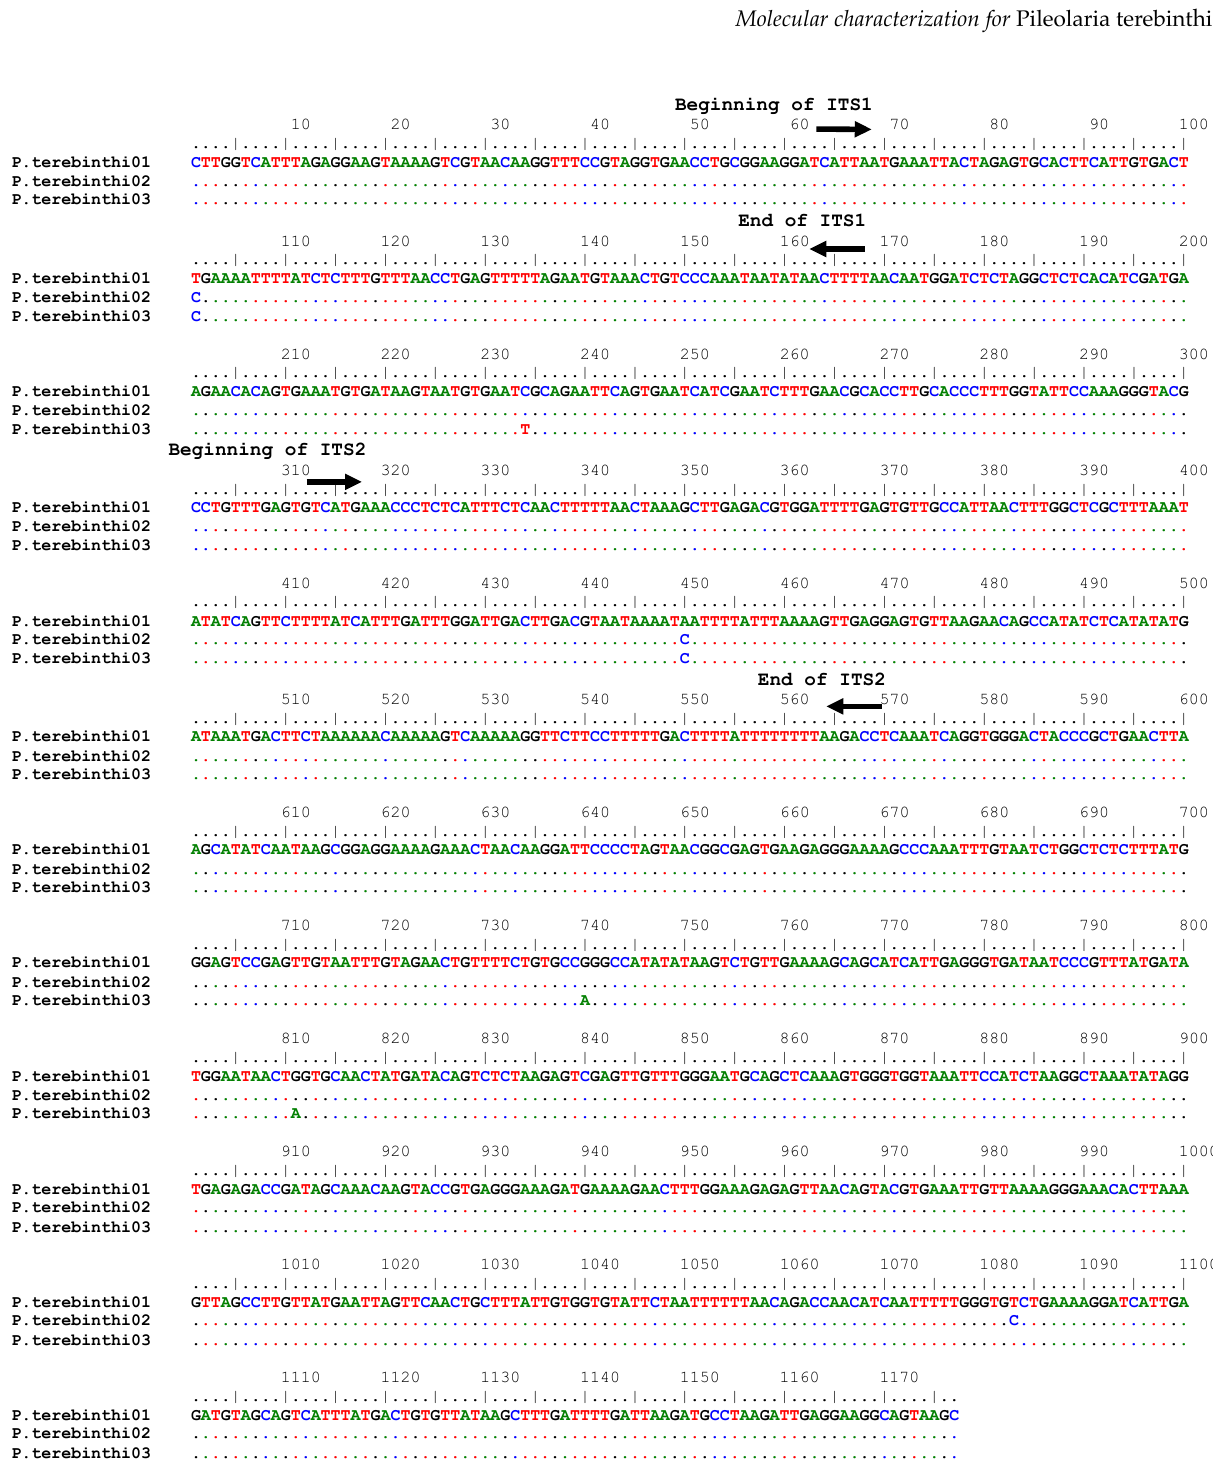
Figure 2. The complete ITS sequence alignment of Pileolaria terebinthi sample R291. The sequences are written 5’ to 3’. Iden - tical nucleotides are indicated by dots. The ITS1 and ITS2 regions are marked with arrows. The sequence was conserved in all samples which differed at position 101, 234, 358 (T instead of C); at position 519 (G instead of A); at position 811 (A instead of G) and at position 1083 (C instead of